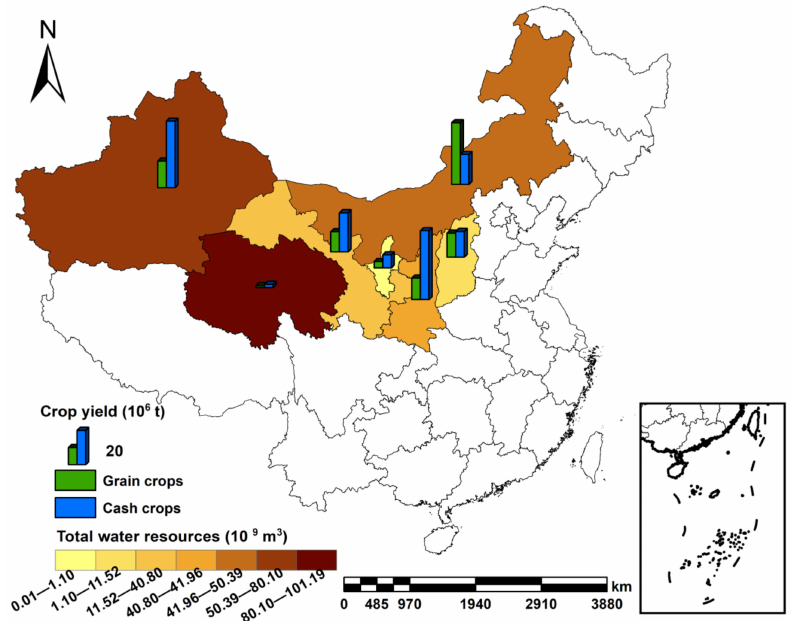
Figure 1. Survey of geography of Northwest China. Note: The data involved in this figure come from the National Bureau of Statistics (http://www.stats.gov.cn/tjsj/, accessed on 6 August